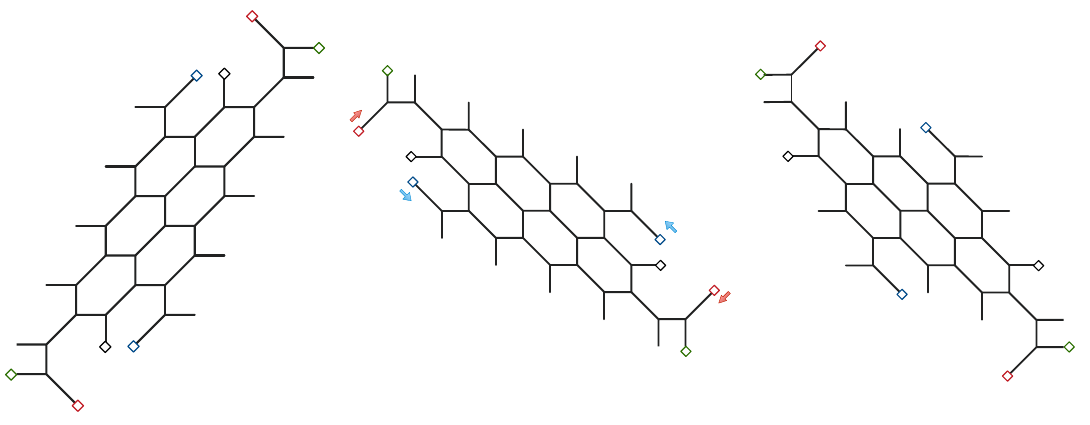
SU(4) 0 SU(4) 0 (cid:0) (cid:0) (cid:0)